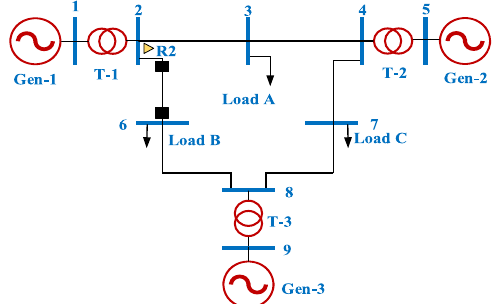
Fig. 4 WSCC 9-bus system for the validation of the proposed